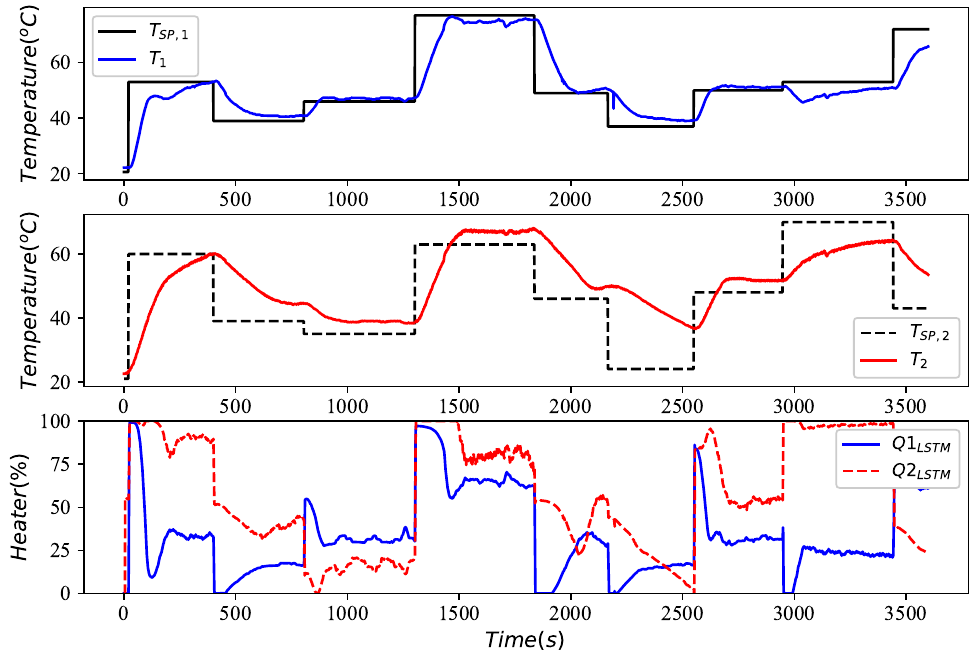
Figure 6. Scenario 1. Temperature and heater output of an approximate MPC control deployed online to a small scale temperature control (target system). The approximate MPC control is trained using only target data.